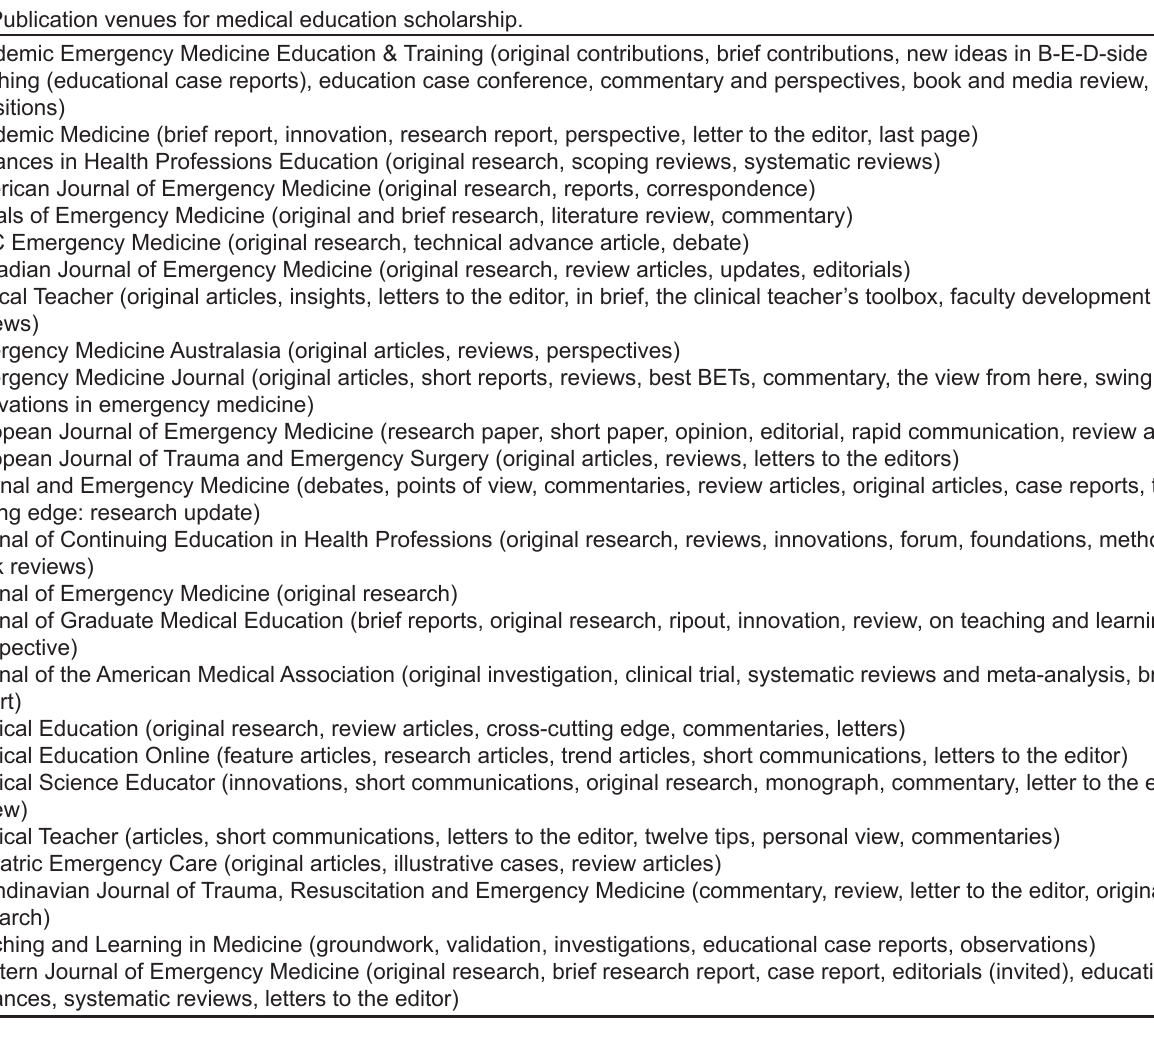
Table 1. Publication venues for medical education